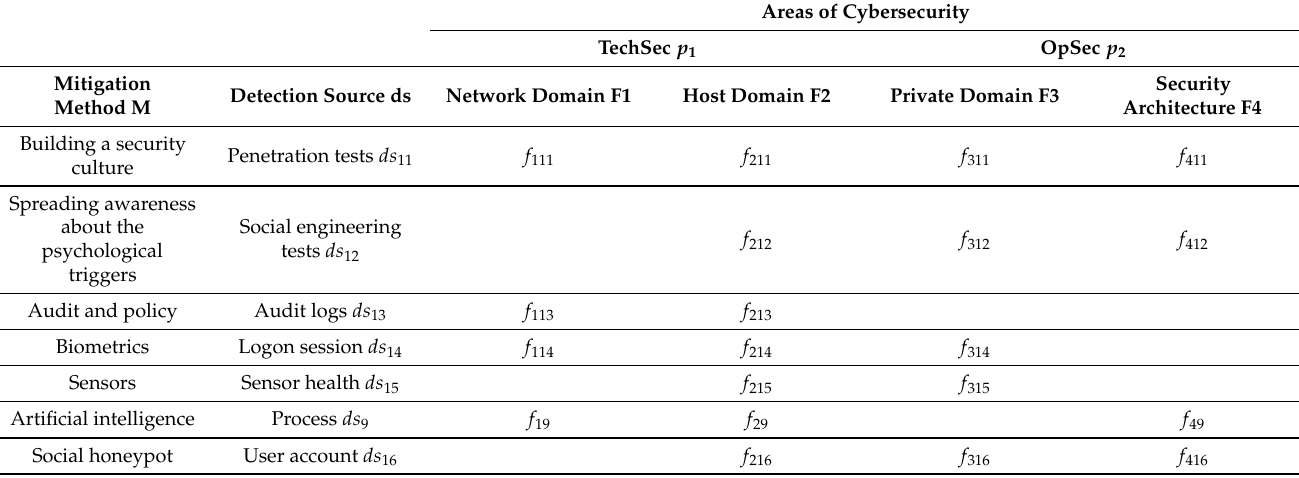
Table 4. Stage 4: Social Engineering.